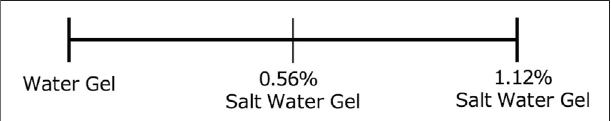
FIGURE 4 | Visual analog scale (VAS) used in the